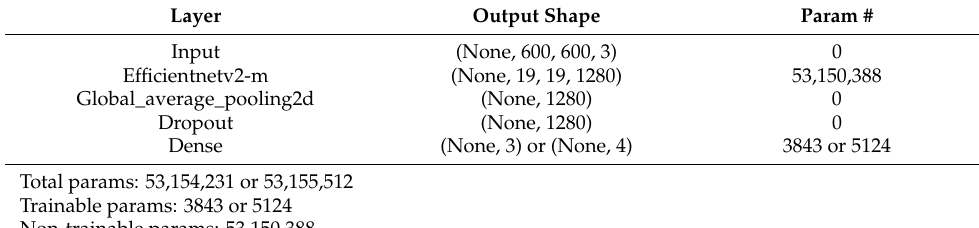
Table 5. Our target model trained on the new top layers of the NIH or SCH data set. Layer Output Shape Param # Input (None, 600, 600, 3)